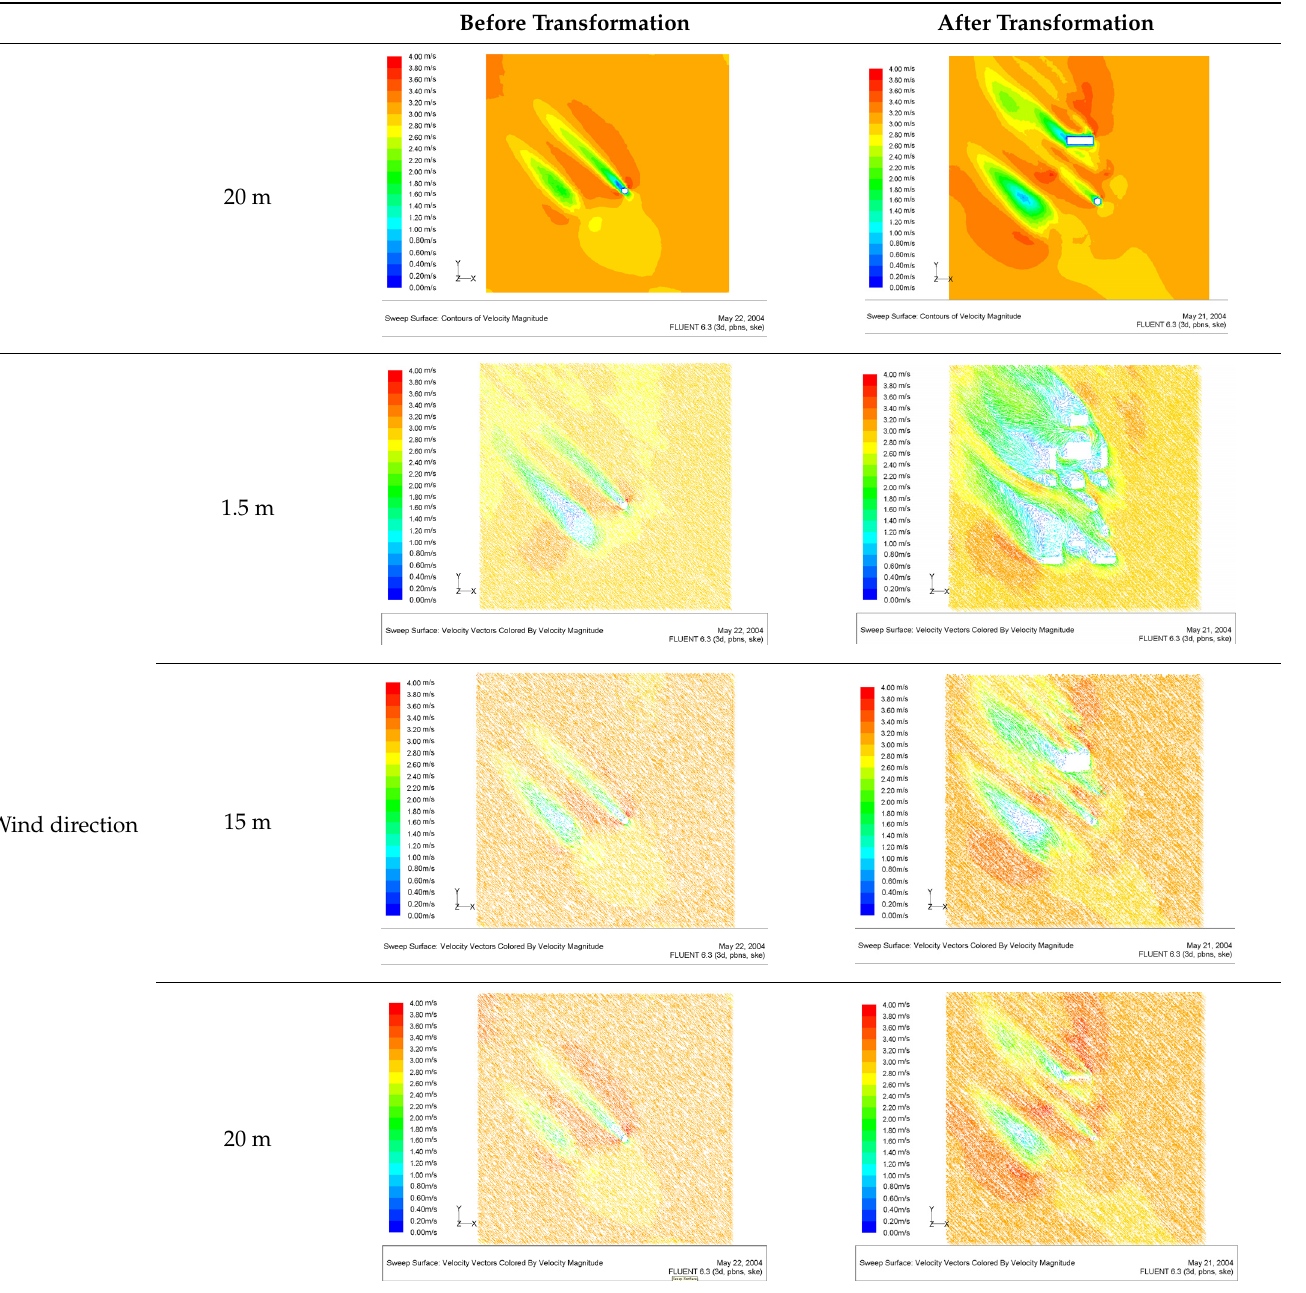
Table 1. Cont. Before Transformation After